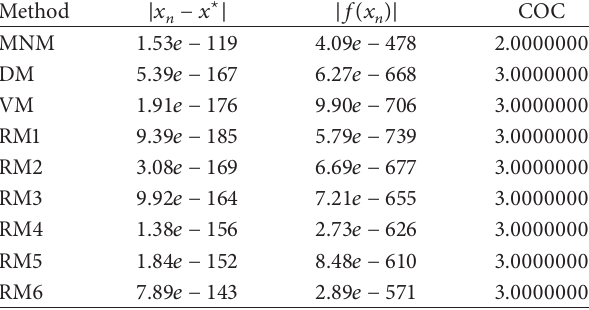
Table 3: Comparison of various iterative methods for the function (𝑥) under the same total number of function evaluations (TNFE) 𝑓 3 required by all